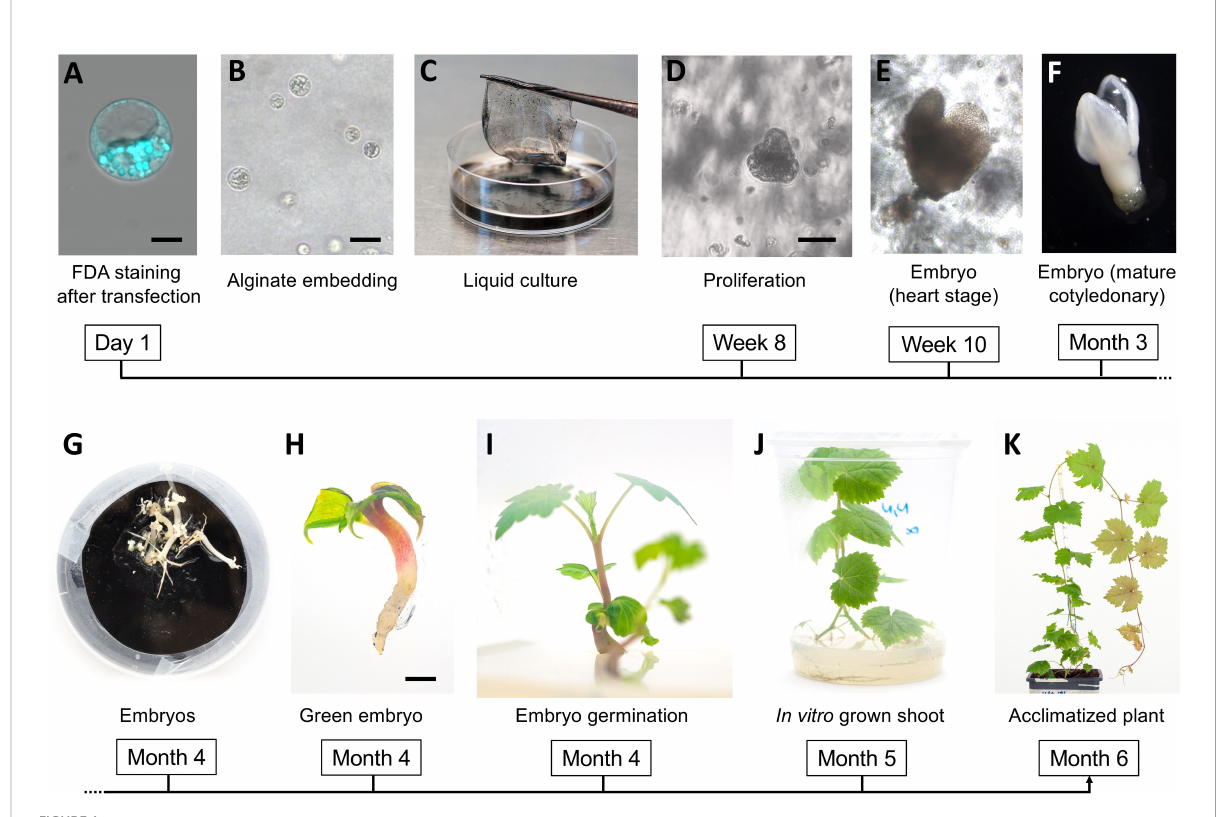
FIGURE 1 Regeneration of grapevine plants from protoplasts. FDA-staining of a viable protoplast from the embryogenic callus digestion mixture after transformation (A) ; protoplast embedded in the alginate disc (B) ; alginate disc set to fl oat in the NN-based medium (C) ; aggregate of proliferating cells (D) and fi rst embryos at heart stage (E) ; embryo at mature cotiledonary stage (F) and fi nal stage (G) on solid GS1CA medium; green embryo after exposure to light (H) ; emerging shoot during embryo germination (I) ; in vitro plant at 40 days after exposure to light (J) ; acclimatized plant at one month after potting (K) . Black magni fi cation bars correspond to 5 m m, 50 m m, 100 m m, and 2mm in (A, B, D, H) ,